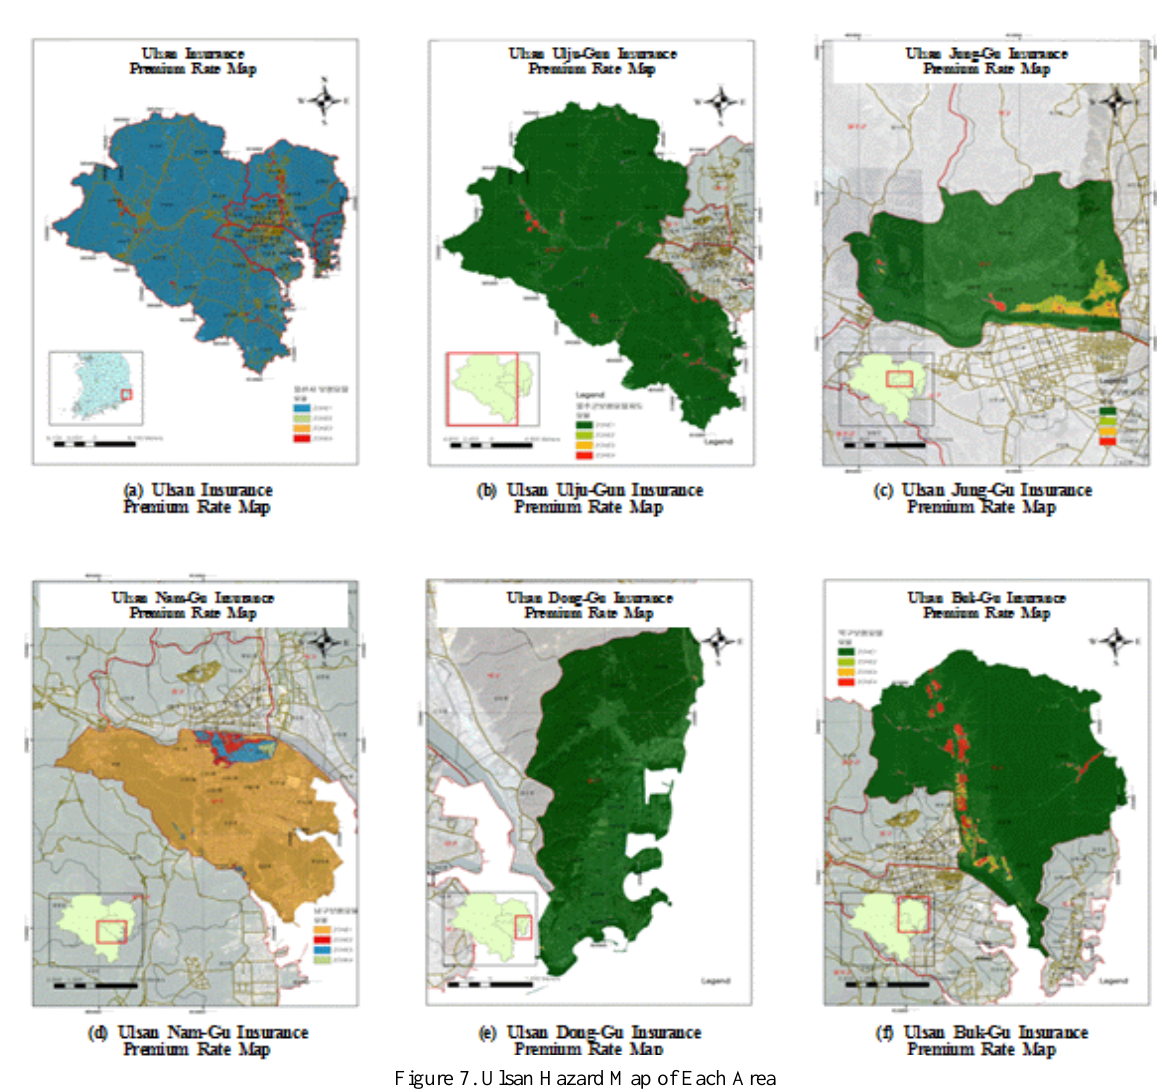
Figure 7. Ulsan Hazard Map of Each